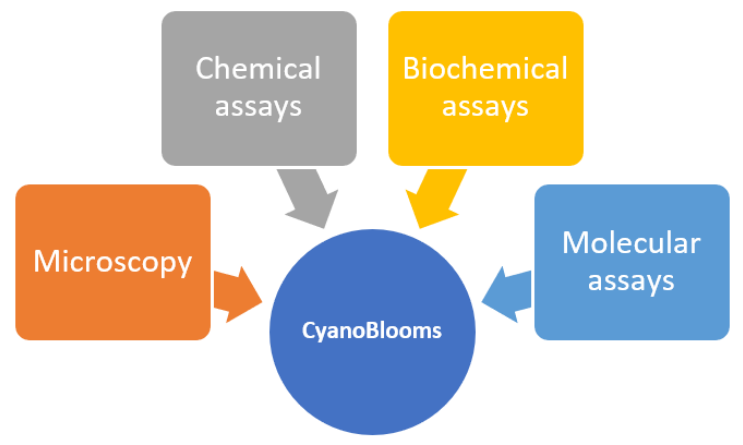
Figure 3. Current methods available in CyanoBloom